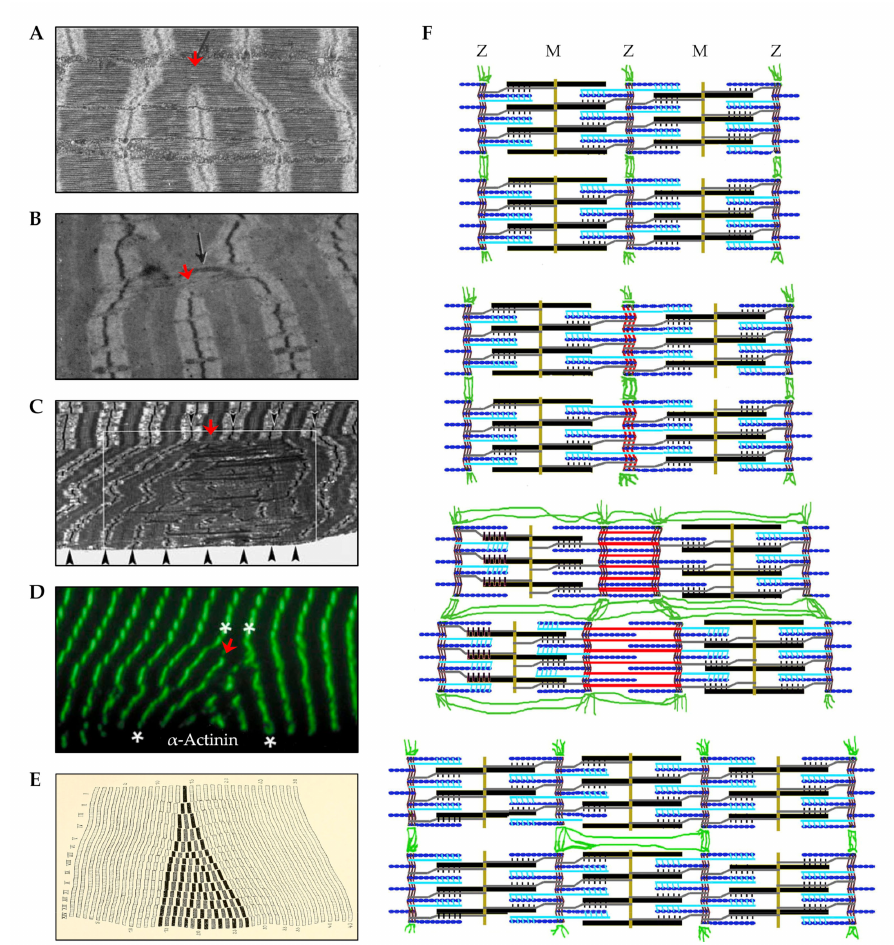
Figure 6. ( A ) Electron micrograph (EM) image that shows a group of myofibrils along with